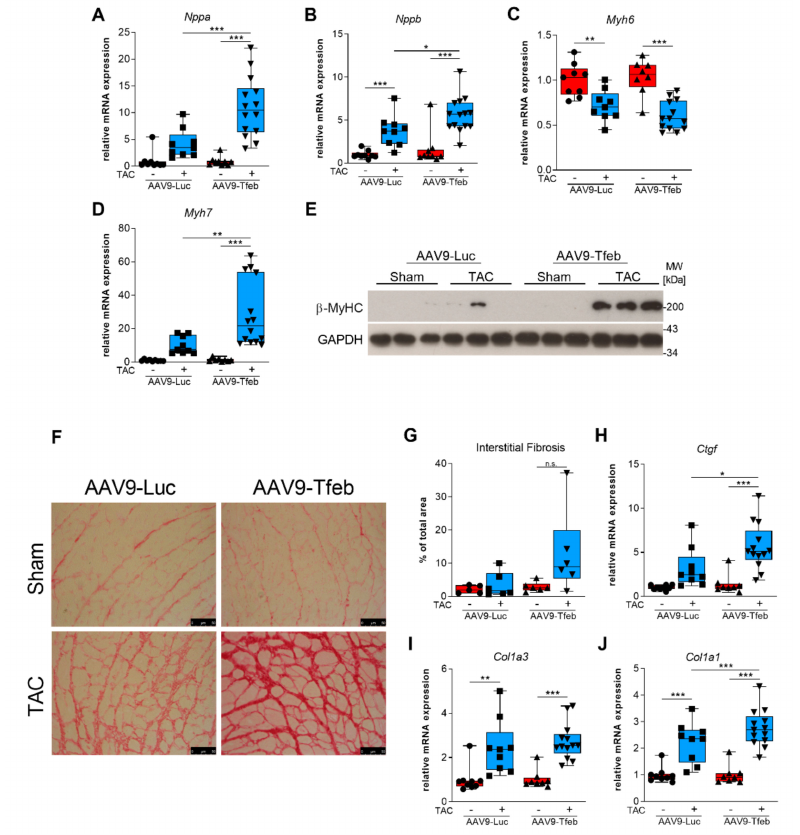
Figure 3. Overexpression of TFEB aggravates pressure-overload-induced cardiac stress response and interstitial fibrosis. qRT-PCR of RNAs isolated from hearts of AAV9-Luc and AAV9-Tfeb mice 28 days after sham and TAC surgery. Gene expression of Nppa (( A ), atrial natriuretic factor), Nppb (( B ), B-type natriuretic peptide, Myh6 (( C ), α -myosin heavy chain), and Myh7 (( D ), β -myosin heavy chain), is shown. Data were normalized to geometric mean of Mrpl13 , Ipo8 and Pgk1 and presented as mean ± SEM. * p < 0.05; ** p < 0.01; *** p < 0.001. ( E ) Western Blot analysis of β -MyHC ( β -myosin heavy chain). Glyceraldehyde-3-phosphate dehydrogenase (GAPDH) protein content was used as loading control. ( F ) Representative Picrosirius Red staining of histological sections from hearts of sham and TAC operated AAV9-Luc and AAV9-Tfeb mice to identify interstitial fibrosis. Scale bars: 50 µ